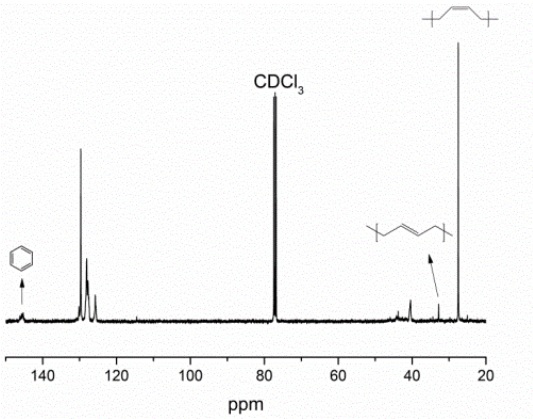
Figure 4. 13 C NMR of HO–SBS–OH, initiator: St:B:St (molar ratio) = 0.02:1:4:1.